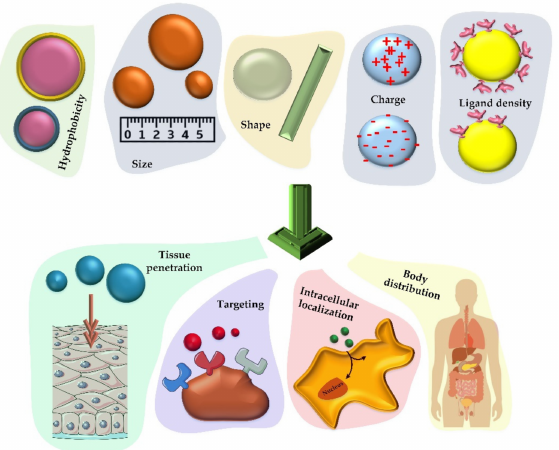
Figure 3. Various chemical and physical properties that can determine how nanoparticles will act as vaccine carriers. The size, hydrophobicity, charge, shape, and ligand density of the nanoparticles that carry the therapeutic factor will have a significant effect on their cellular uptake, distribution in the body, accumulation in the cell (especially phagocytic cells) and the rate of tissue